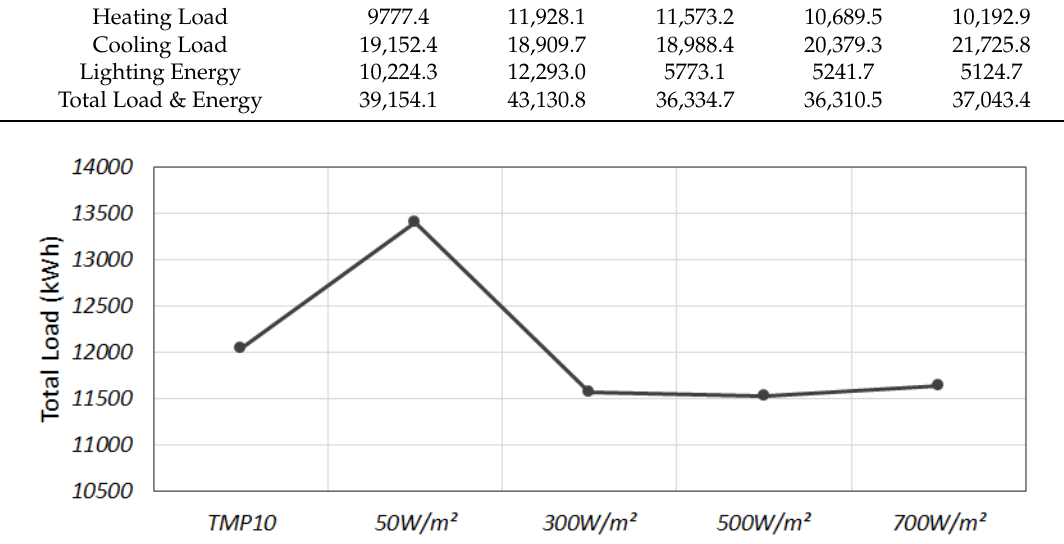
Table 10. Electrochromic glass’ controlling conditions and annual energy consumption rate.